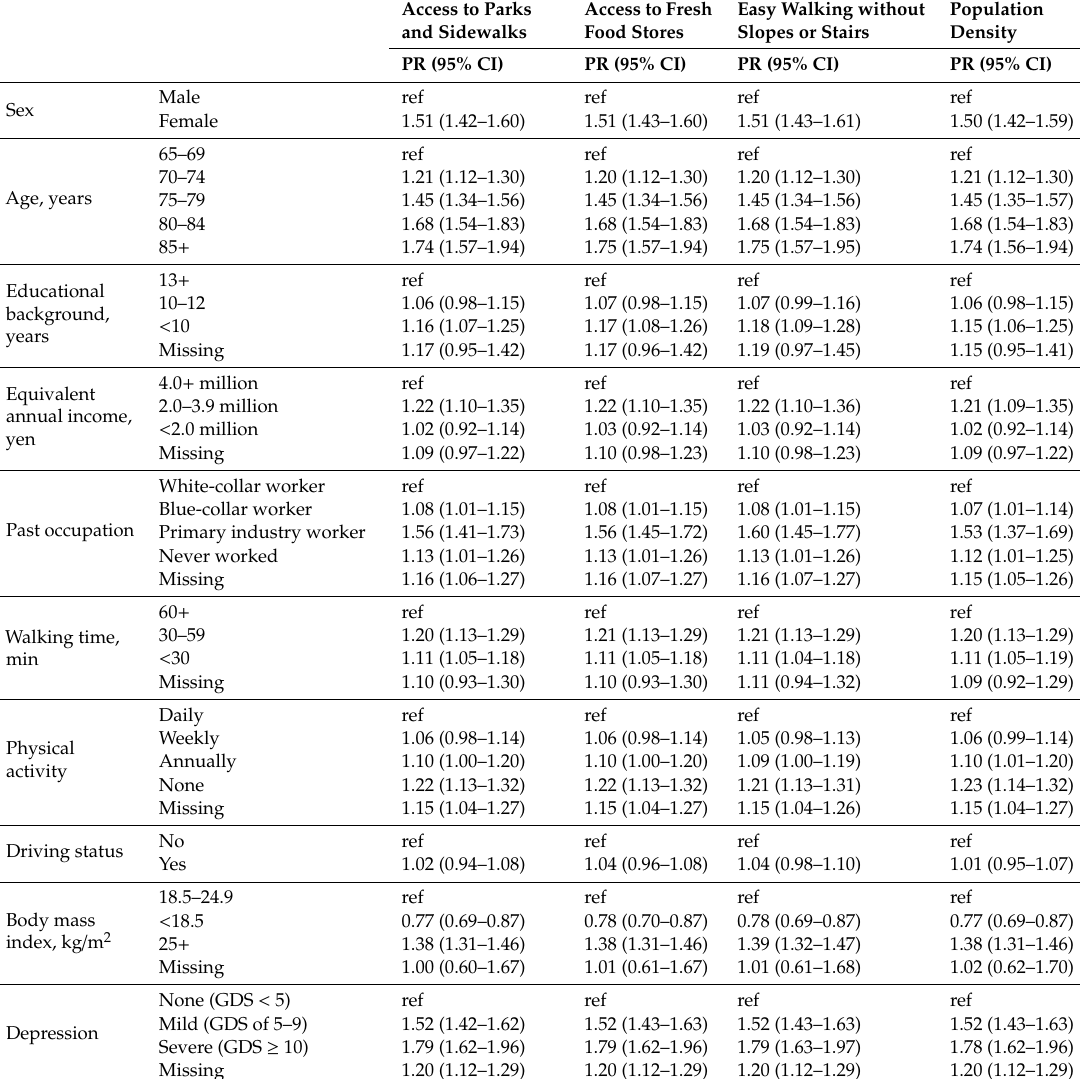
Table A1. Association between covariates and knee pain by multilevel Poisson regression analysis ( n =